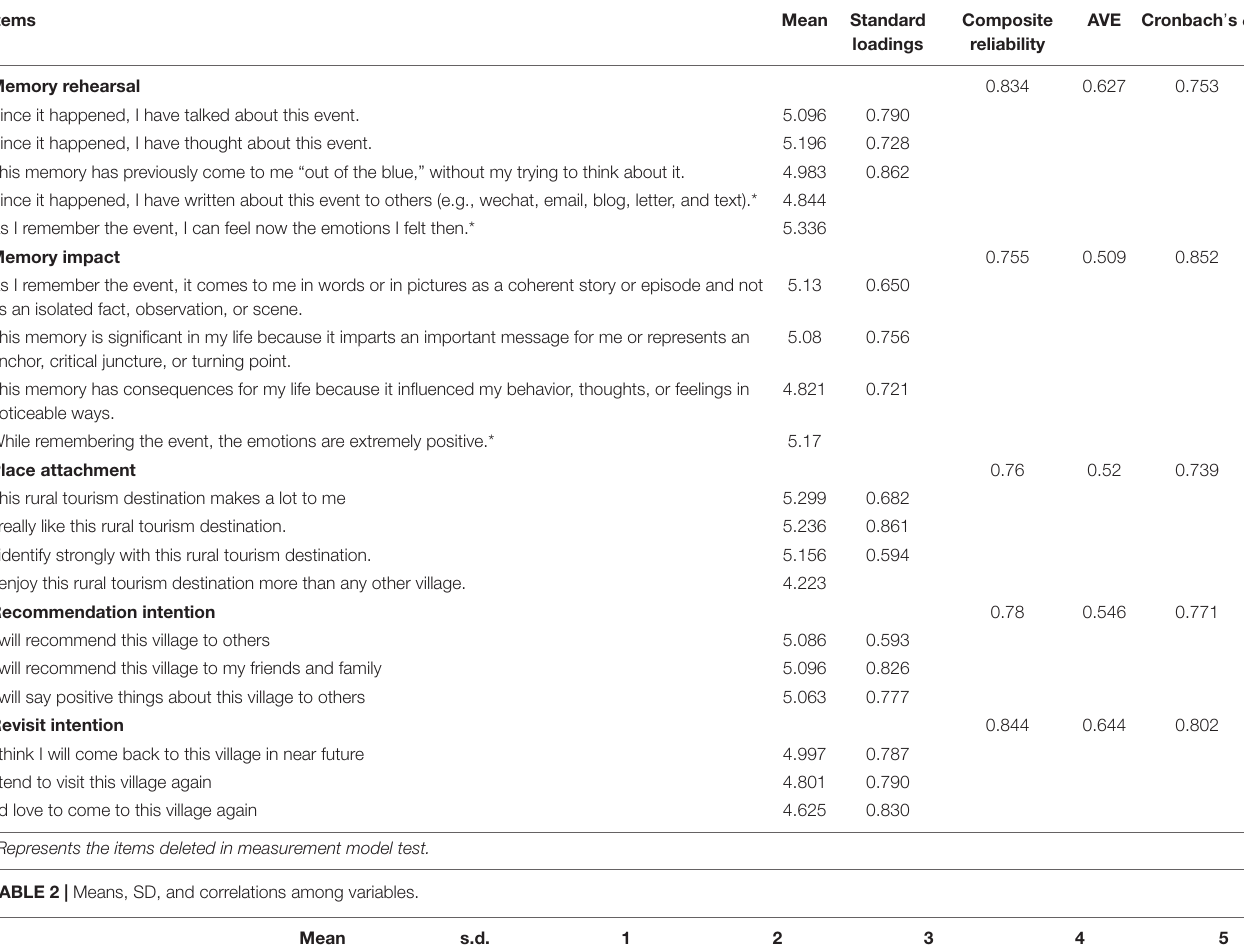
TABLE 1 | Assessment of measurement model. Items